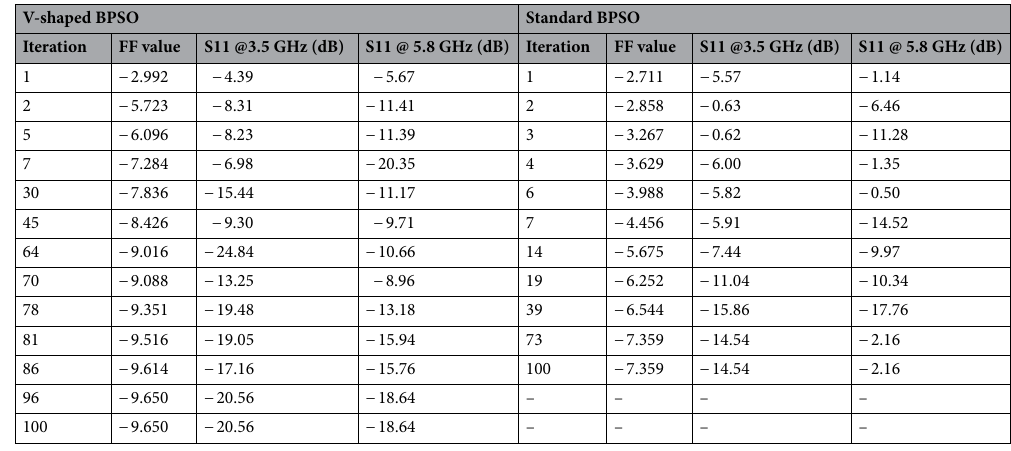
Table 2. Comparison of pixelization results using VBPSO and BPSO.